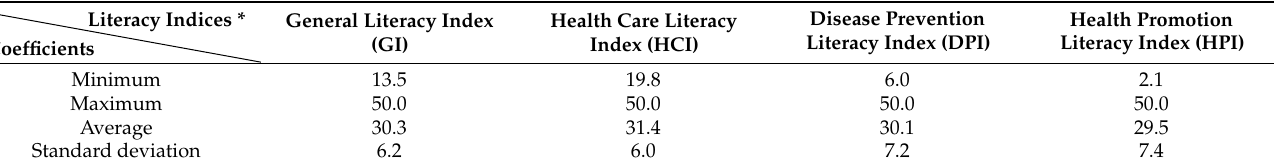
Table 2. Participants’ levels of health literacy.